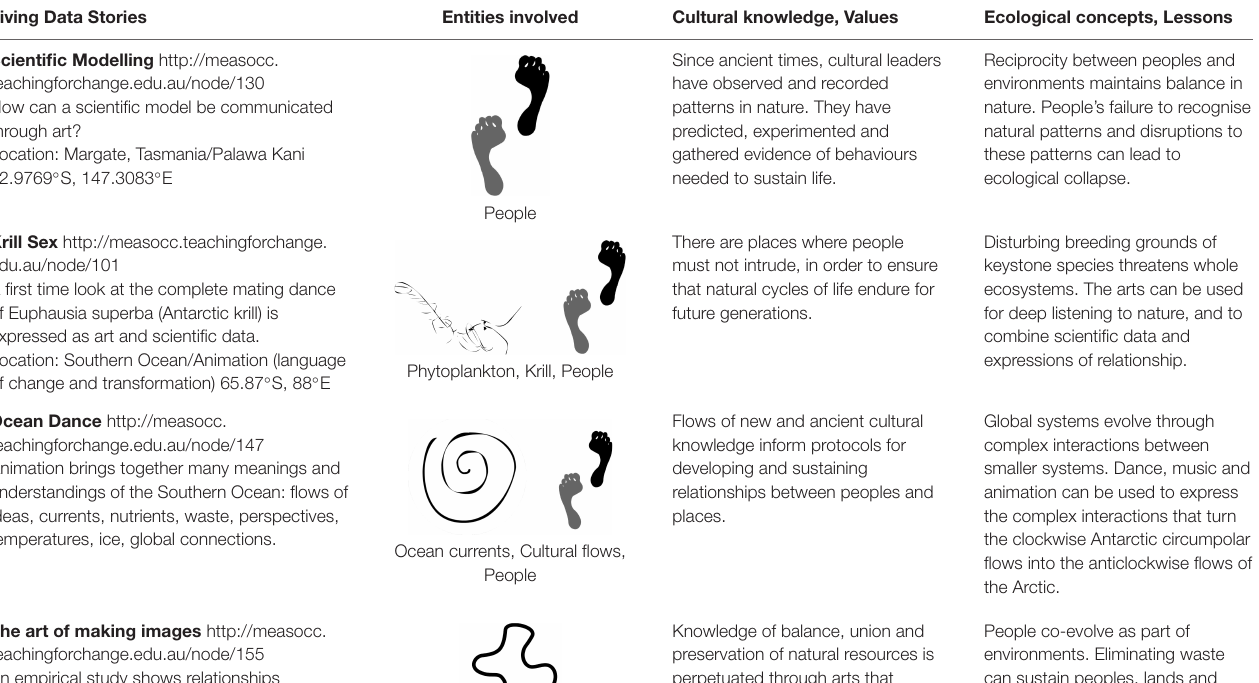
TABLE 1 | Stories conveyed through the interactive web-based map of MEASO Cultural Connections